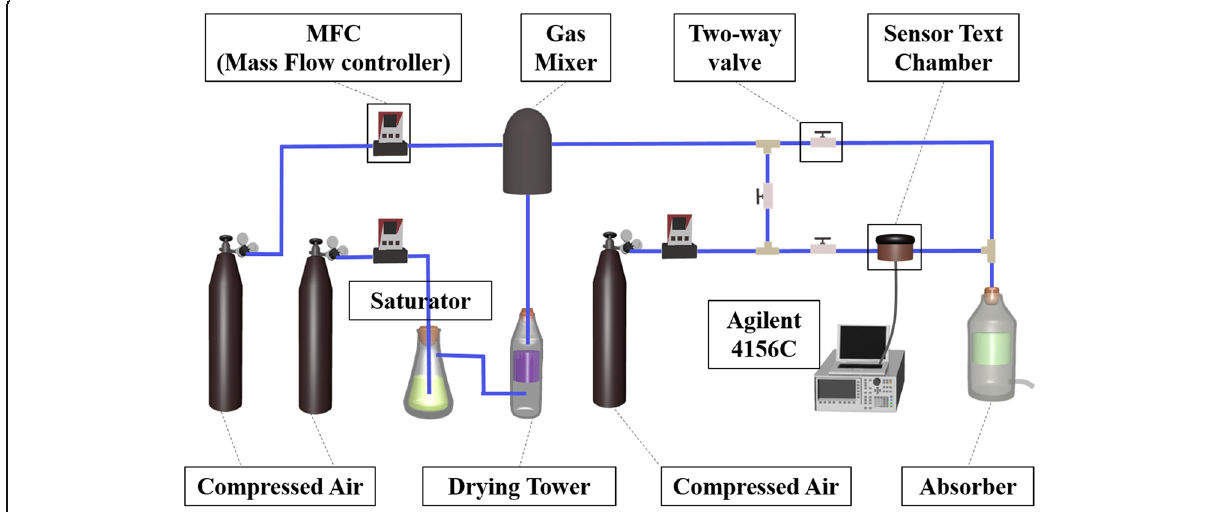
Fig. 1 Schematic diagram of experimental setup for gas-sensing test